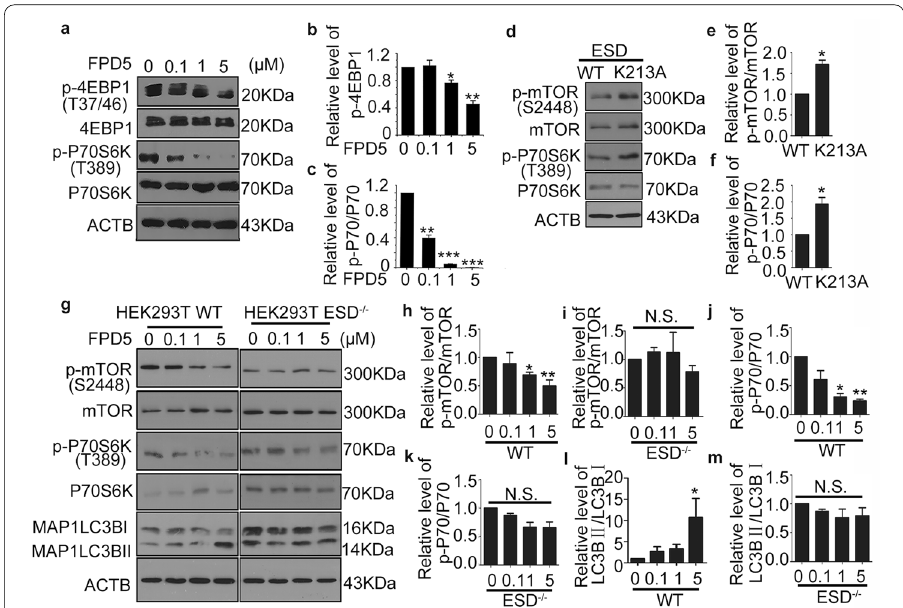
Fig. 2 ESD suppressed mTORC1 activity. a – c Western blot analysis of 4EBP1, phosphorylated 4EBP1 (p-4EBP1, Thr37/46), P70S6K, and phosphorylated P70S6K (p-P70S6K, Thr389) level in A549 cells treated with FPD5 at 0–5 μM for 24 h. d – f HEK293T cell line was transfected with plasmids pCAG-ESD-WT and pCAG- ESD - K213A for 48 h followed by western blot analysis of the level of p-mTORC1 and p-P70S6K. g – m Western blot analysis of mTORC1, phosphorylated mTORC1, P70S6K, phosphorylated P70S6K (p-P70S6K, Thr389) and MAP1LC3BII level in HEK293T-WT and HEK293T-ESD − / − treated with FPD5 at 0.1–5 μM for 24 h. Data are mean SEM. ± *p < 0.05, **p < 0.01, ***p < 0.001; N.S., not significant, n =